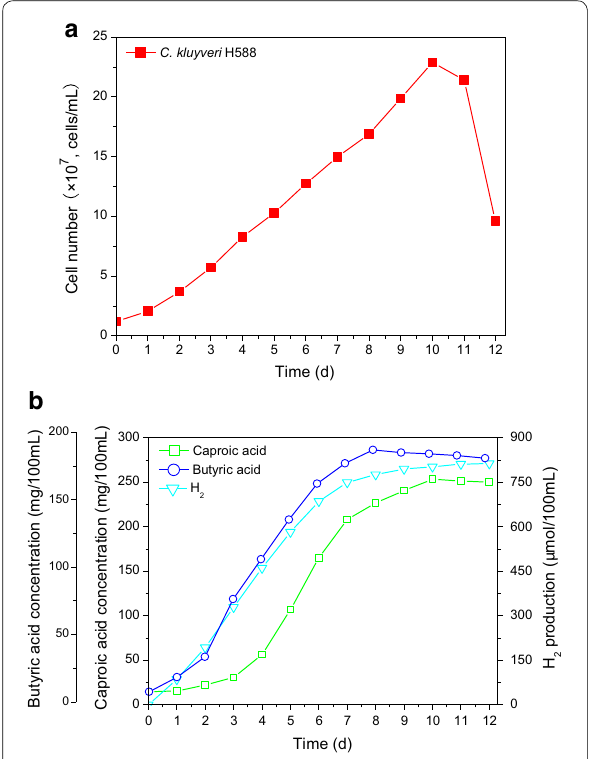
Fig. 1 Time courses of cell growth ( a ), caproic acid, butyric acid and H 2 production ( b ) for the mono-culture fermentation